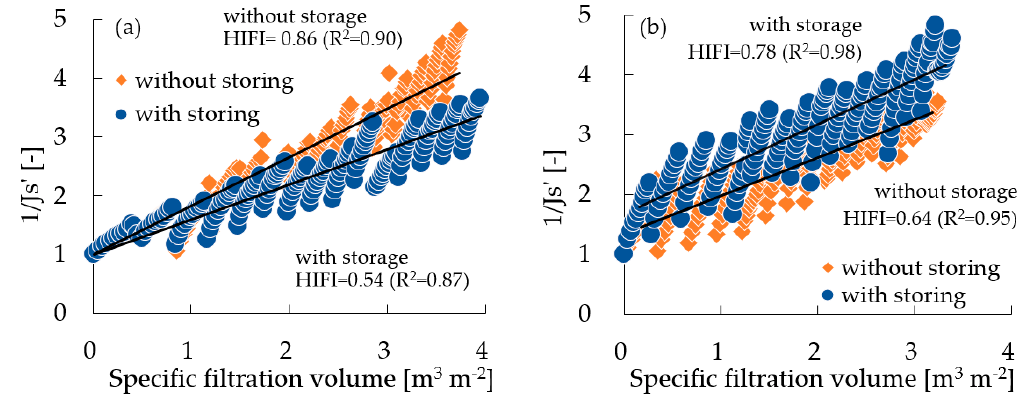
Figure 6. Profiles of average hydraulically irreversible fouling index (HIFI) of November 2014 ( a ) and 2015 March ( b ) ( n = 2).